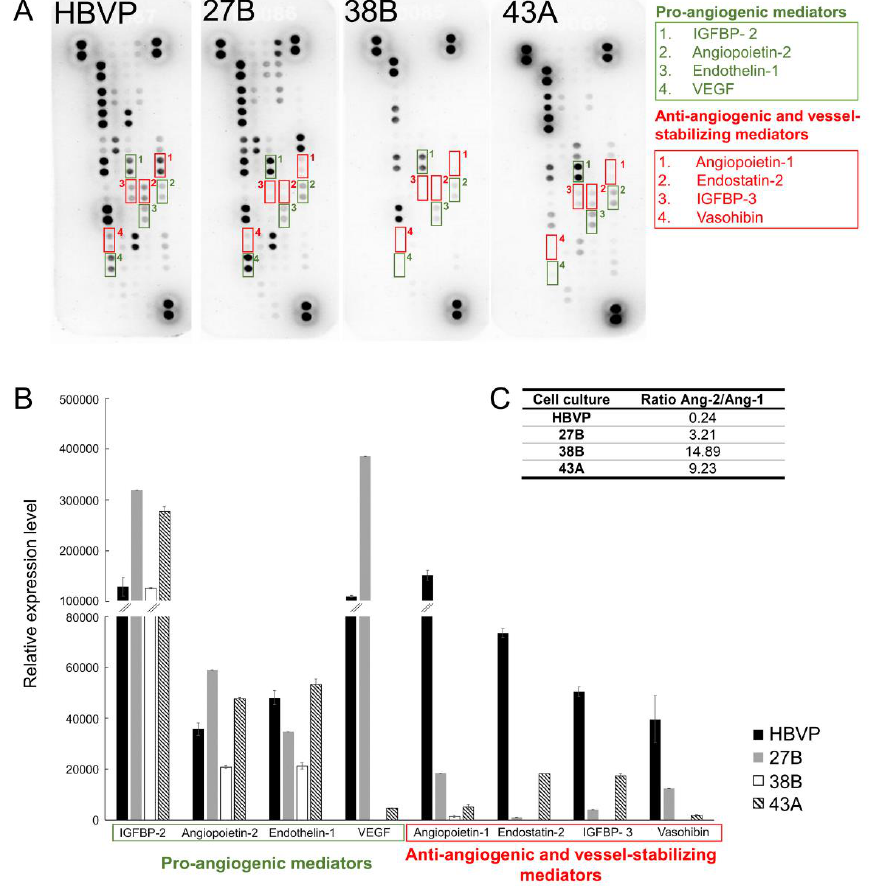
Figure 8. FAP + mesenchymal cells from human glioblastomas produce mediators that regulate